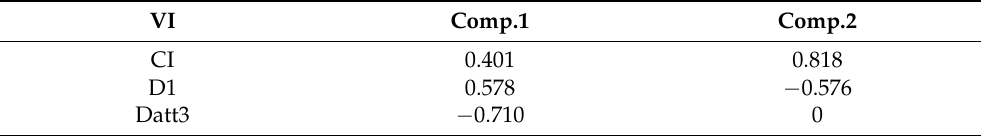
Table 10. Factor loads on the main components for Ambrosia artemisiifolia , Atriplex tatarica , Glycyrrhiza glabra , Euphorbia seguieriana , and Setaria pumila .